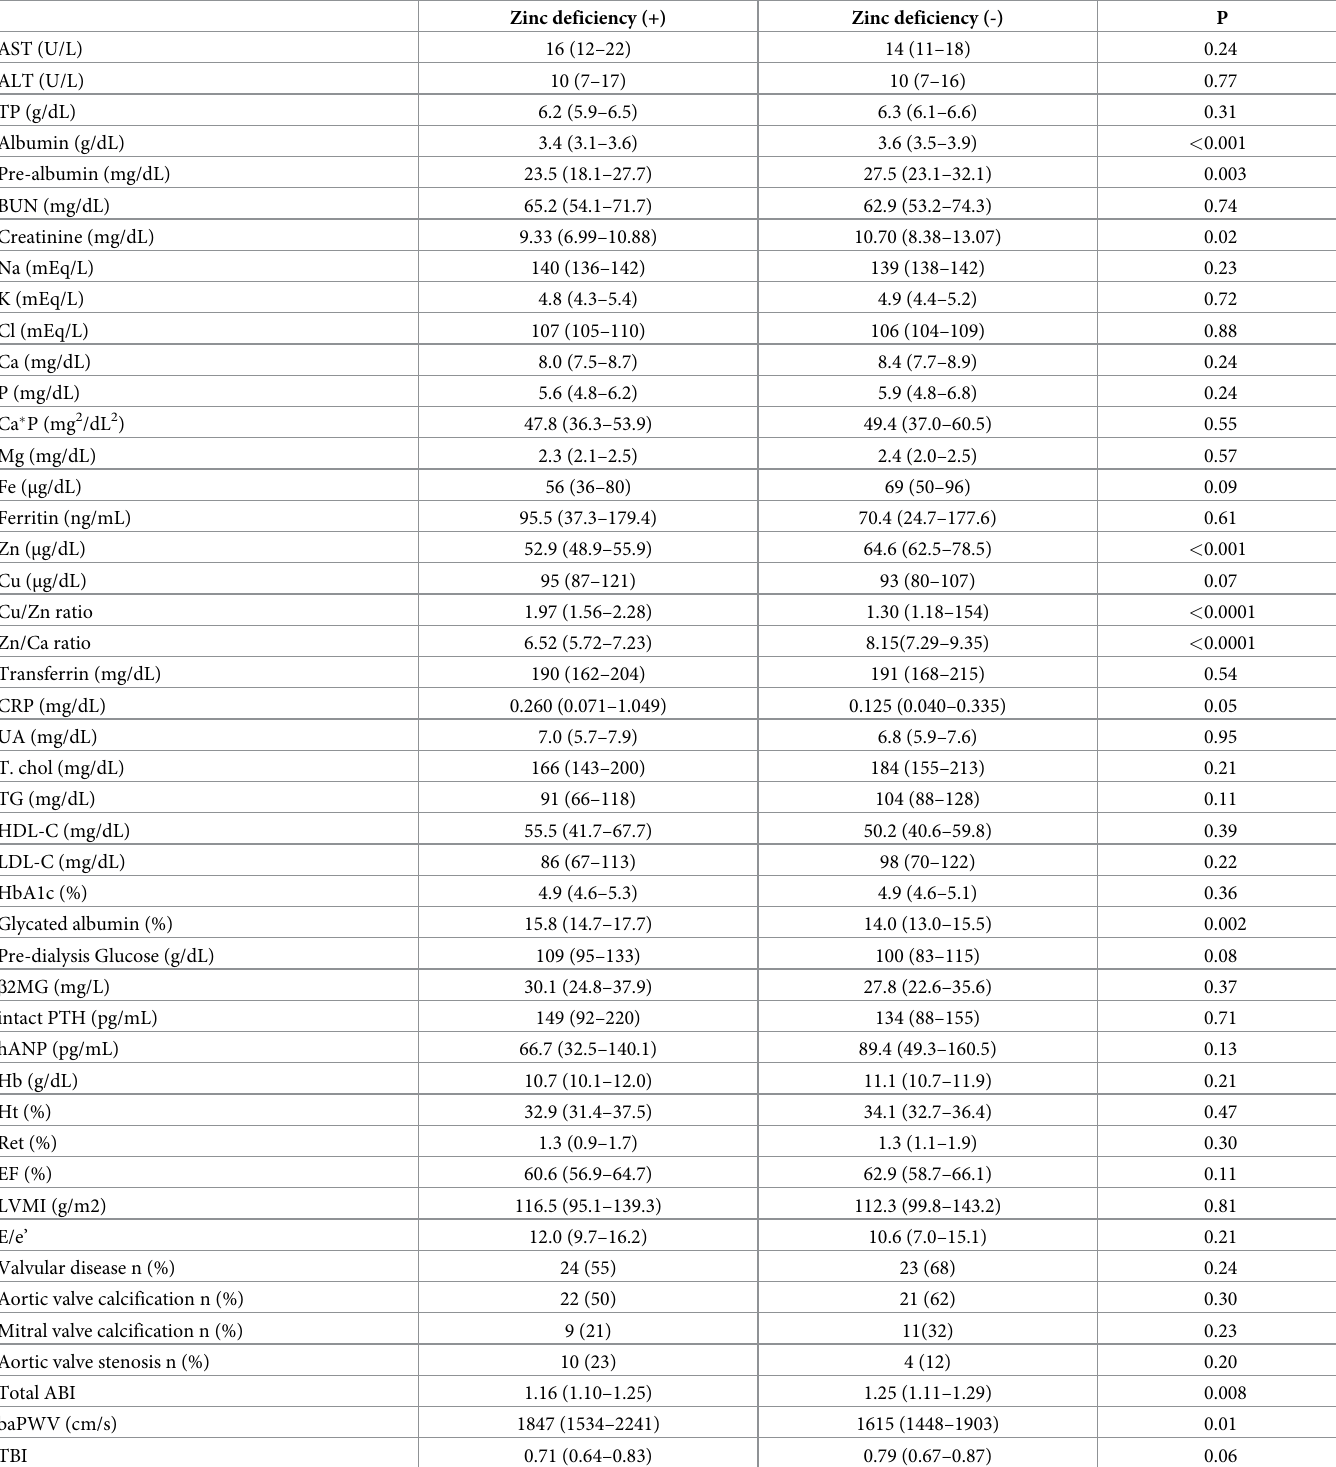
Table 2. Blood sampling and physiological test results of the zinc deficiency and non-deficiency